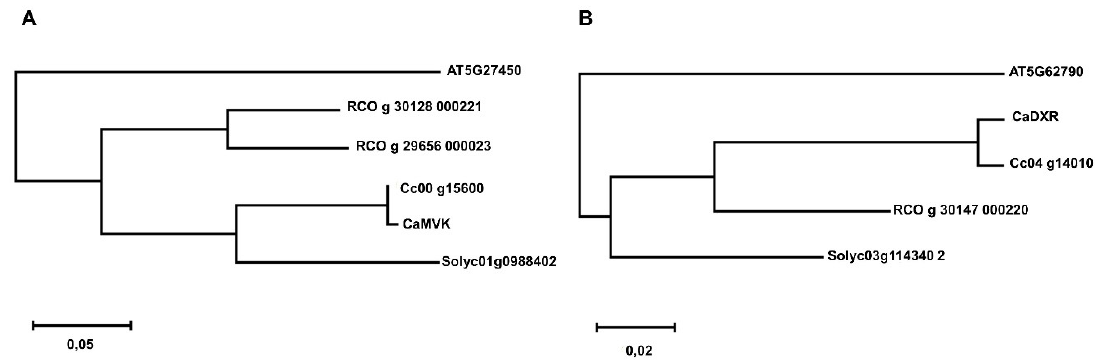
Figure 4. Phylogenetic analysis of MVK and DXR C. arabica transcripts using five selected species ( A. thaliana, C. arabica, C. canephora, R. communis and S. lycopersicum ). The tree was drawn using the maximum likelihood method, which was based on the LG